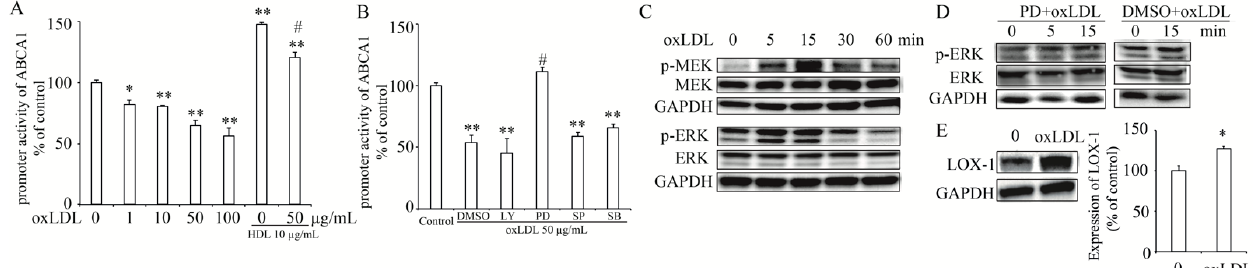
Figure 4. OxLDL suppressed ABCA1 promoter activity via MEK/ERK pathway in INS-1 cells. ( A ), the effect of OxLDL or HDL on ABCA1 promoter activity. ( B ), the effects of a PI3K inhibitor LY294002 (LY), a MEK inhibitor PD98059 (PD), a JNK inhibitor SP600125 (SP) or a p38 MAPK inhibitor SB203580 (SB) with or without OxLDL on ABCA1 promoter activity. Percentage of promoter activity is referred to control. ( C ), phosphorylation of MEK at Ser217/221 and ERK at Thr 202/Tyr 204 in INS-1 cell treated with OxLDL. ( D ), phosphorylation of ERK at Thr 202/Tyr 204 after inhibition of MEK by PD98059 (PD) in INS-1 cells treated with OxLDL. ( E ), the protein expression of LOX-1 in INS-1 cells treated with OxLDL. The ratio is shown as percent of control.Data is presented as the mean ± SEM ( n = 3) of separate experiments for each treatment group. * p < 0.05, ** p < 0.01 compared to 0 or control; # p < 0.05 compared to OxLDL at 50 μ g/mL or DMSO plus OxLDL.